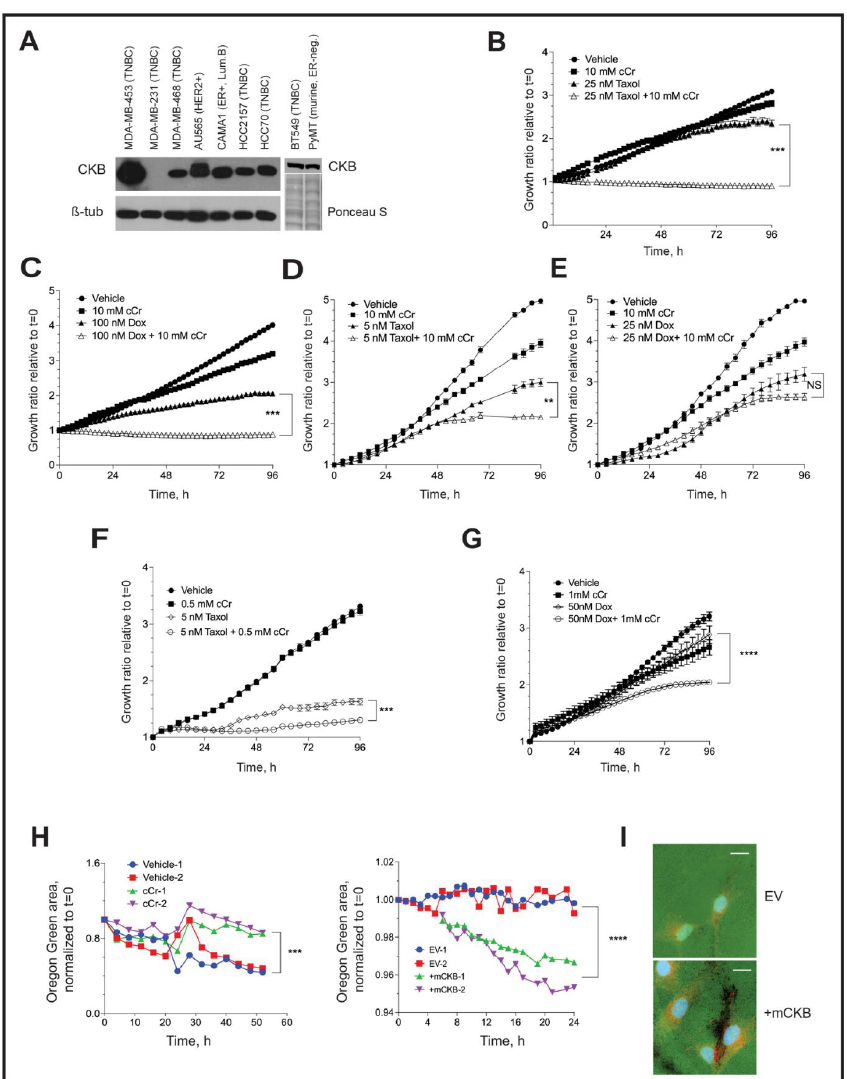
Figure 7. Cyclocreatine is synergistic with, or additive to, two conventional chemotherapies, and cyclocreatine inhibits the formation of invadopodia. ( A ) ( Left ) Western blotting for endogenous CKB protein in a panel of human breast cancer cell lines ( β -tubulin, loading control). ( Right ) Western botting for CKB protein in BT549 TNBC cells and HIF-1 WT PyMT cells in a separate blot. BT549 cells express similar levels of CKB protein to PyMT HIF-1 WT cells; equivalent loading is indicated by Ponceau S staining. ( B – G ) The growth ratio (all treatments are normalized to their respective t = 0 cell density) over time when human MDA-MB-468 TNBC cells ( B , C ), BT549 TNBC cells ( D , E ) or MDA-MB-453 TNBC cells ( F , G ) are cultured in the presence of vehicle, cCr alone, or cCr with Taxol ( B , D , F ) or doxorubicin ( C , E , G ) for 96 h. H. Loss of Oregon Green-conjugated gelatin was measured in the IncuCyte S3 live-cell imager after seeding cells onto gelatin-coated coverslips in the presence of an MMP inhibitor, and then the replacement of growth medium with or without cCr, as described in the Materials and Methods. Quantification data over time are shown for vehicle-treated versus cCr- treated BT549 cells (( H ), Left panel) or for MDA-MB-231 empty vector (EV) or MDA-MB-231 +mCKB cells (( H ), Right panel). Two coverslips were measured simultaneously at each time point across each coverslip/well ( n = 16 independent images/coverslip/timepoint). Data are representative of three independent experiments. ( I ) Example immunostaining images of invadopodia at experimental endpoint co-stained with cortactin (red) and DAPI (630 × magnification, scale bar represents 20 µ M). All images were captured with identical laser intensity and exposure